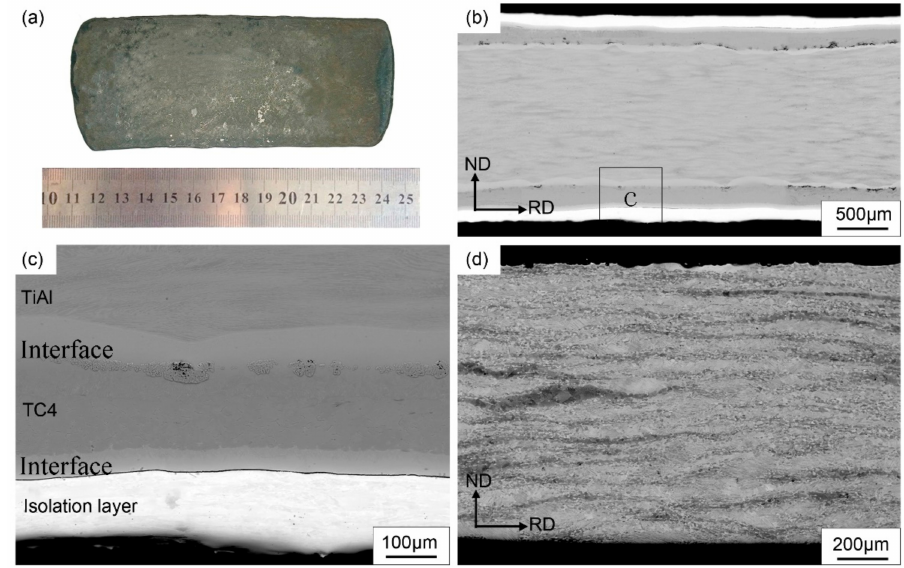
Figure 5. Macro and microstructural characteristics of the pack-rolled Ti-46Al-8Nb alloy with the complex package design: ( a ) macrograph of TiAl sheet, ( b , c ) the contact interface, and ( d ) microstructure of hot-rolling TiAl